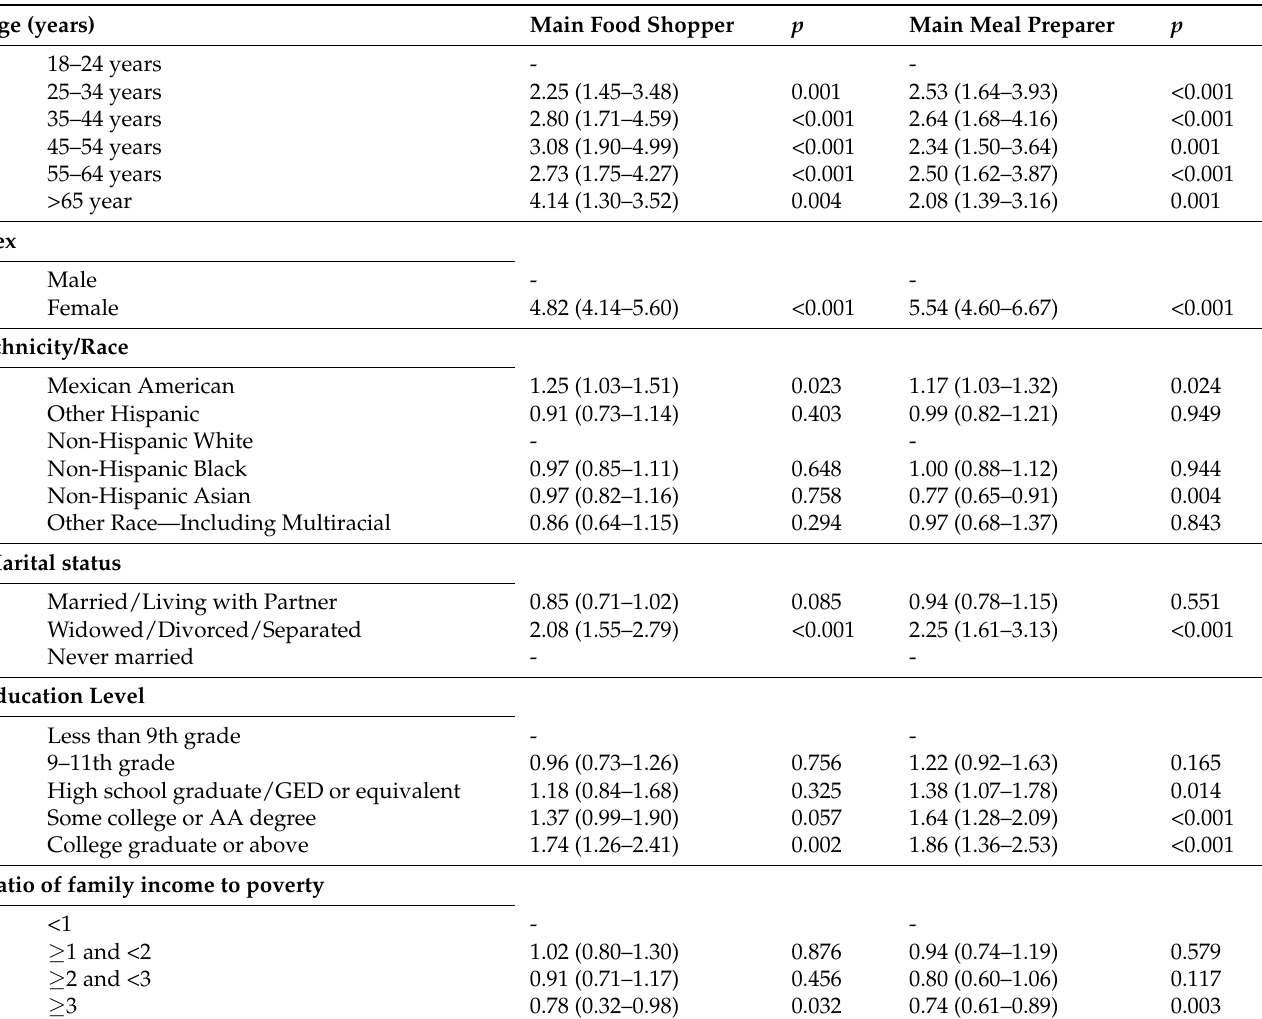
Table 6. Logistic regression models to ascertain the effects of sex on the likelihood of being mainly responsible for shopping (main food shopping duty) and preparing meals (main planning/preparing) duty) after adjustment for selected covariates (age, ethnicity, marital status, education level and ratio of family income to